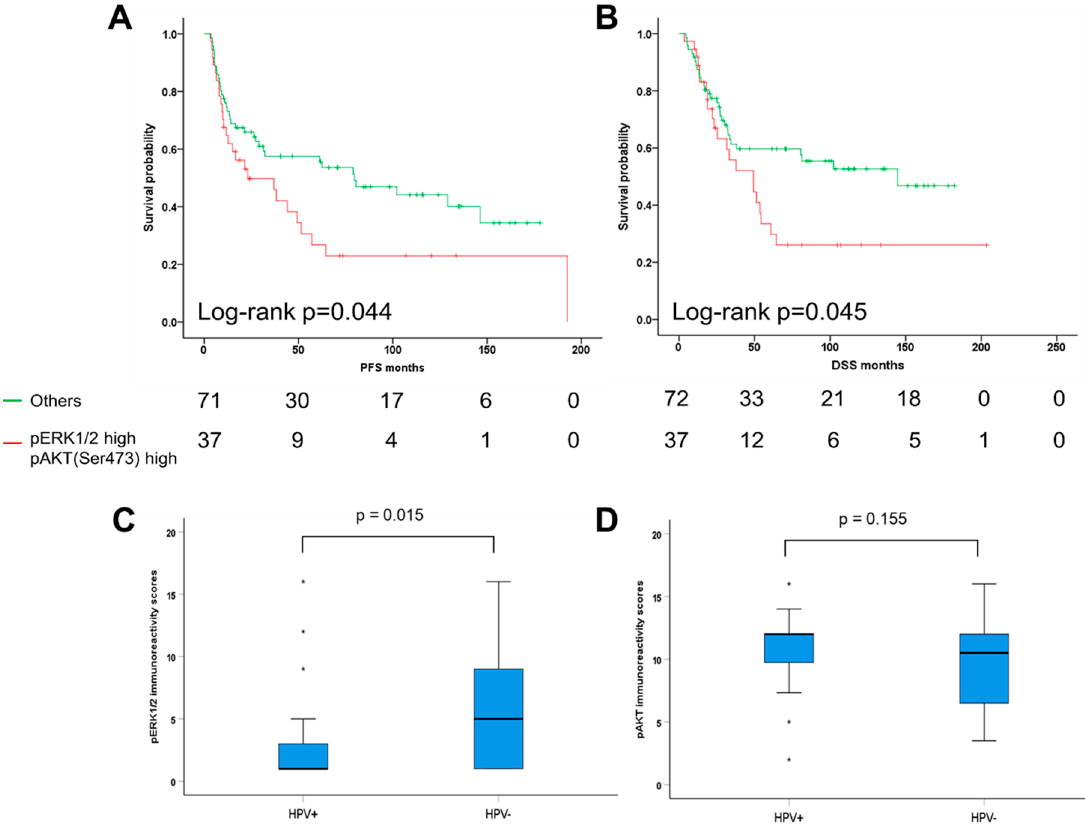
Figure 4. Correlation survival analysis between ERK1/2 and AKT phosphorylation. Kaplan–Meier plots for progression-free ( A ) and disease-specific survival ( B ) revealed that patients with co-activation of both pathways MEK1/ERK1/2 and PI3K/AKT have an unfavorable clinical outcome as compare to others. The number of survivors after a certain time interval (given in months) is displayed. Boxplot depicts the immunoreactivity scores of pERK1/2 ( C ) and pAKT (Ser473) ( D ) between human papillomavirus (HPV) negative and positive oropharyngeal squamous cell carcinoma (OPSCC) patients (HPV+: HPV-positive, HPV − : HPV-negative).